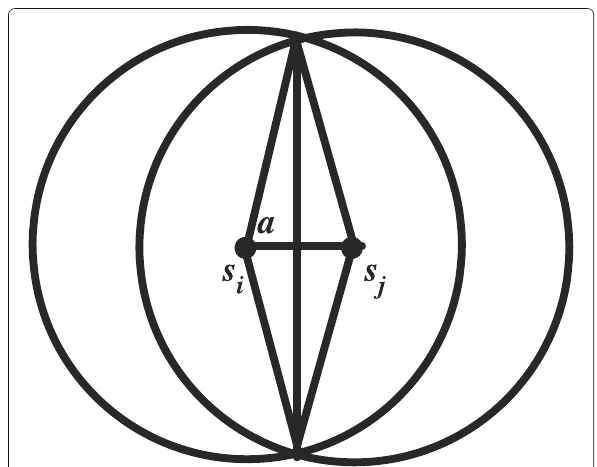
Fig. 1 The intersection section of the two circles